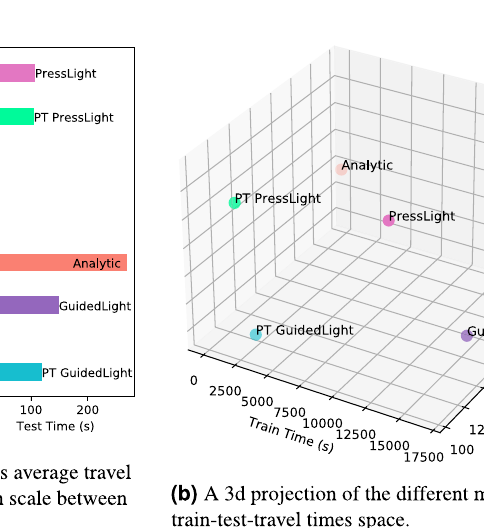
Figure 4. Training and test times vs. the avg. travel time on the NY196 scenario. PT stands for